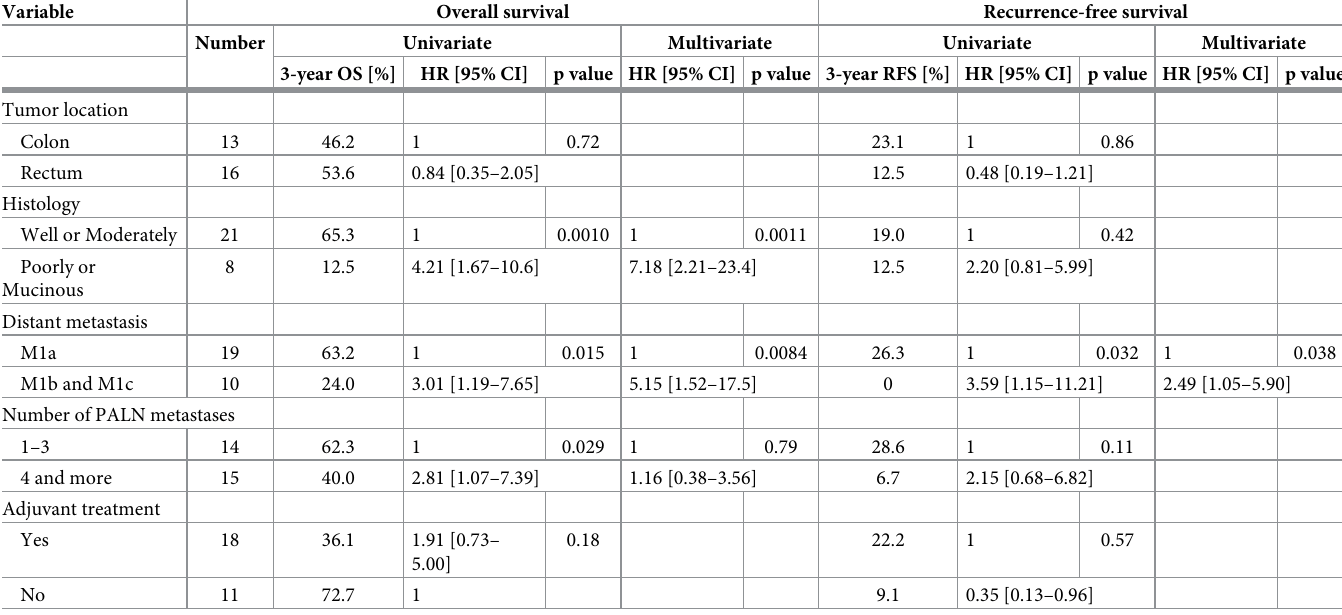
Table 4. Univariate and multivariate analyses of overall survival and recurrence-free survival.